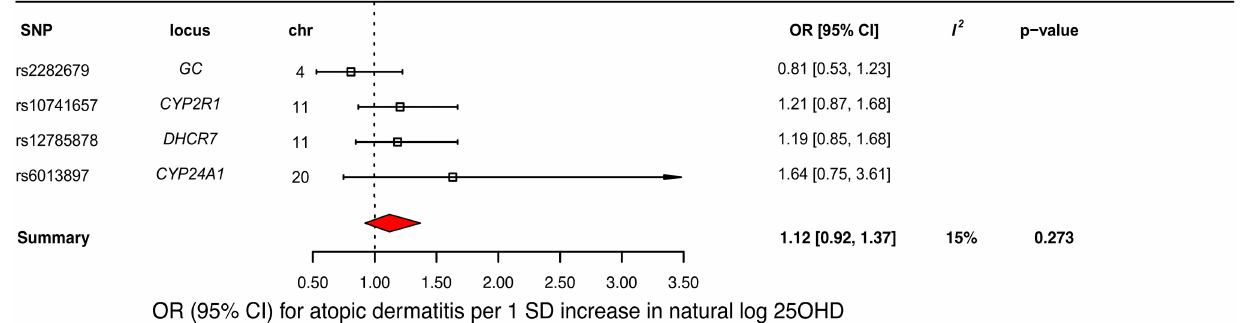
Fig 5. Mendelian randomization estimate of the association of 25-hydroxyvitamin D 25OHD levels with risk of atopic dermatitis. Estimates obtainedfrom using a fixed-effects model. 95% CI, 95% confidenceinterval; chr, chromosome, OR, odds ratio; SD, standard deviation; SNP, single-nucleotide polymorphism.